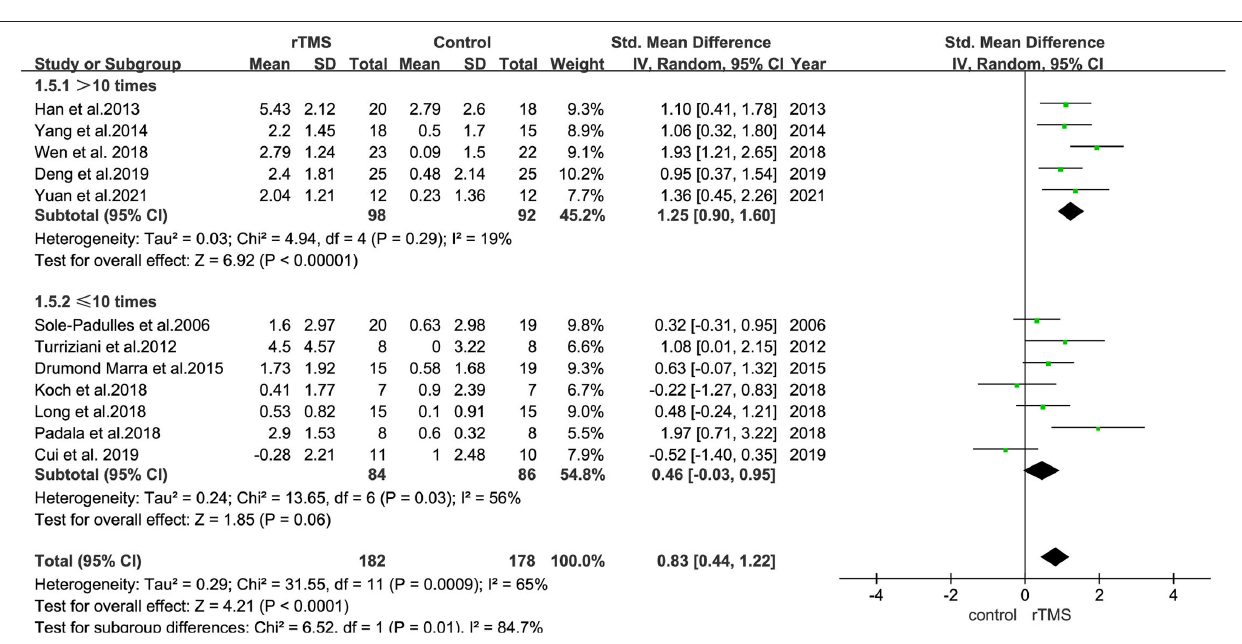
10 treatments). Mean differences in ≤